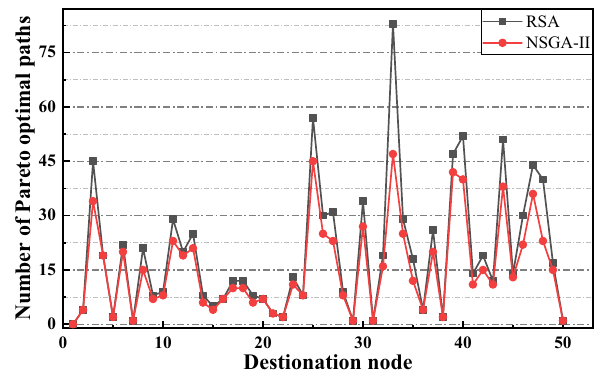
Fig. 13 The TPN of the RSA and NSGA-II in the one-to-all FMOPOP